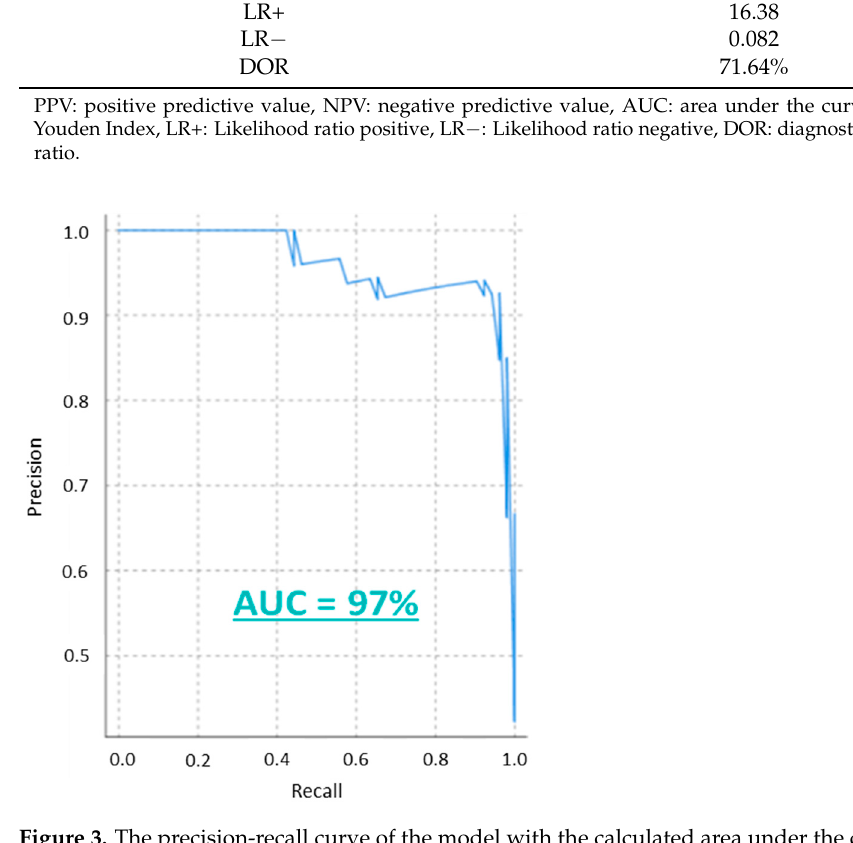
Figure 3. The precision-recall curve of the model with the calculated area under the curve.